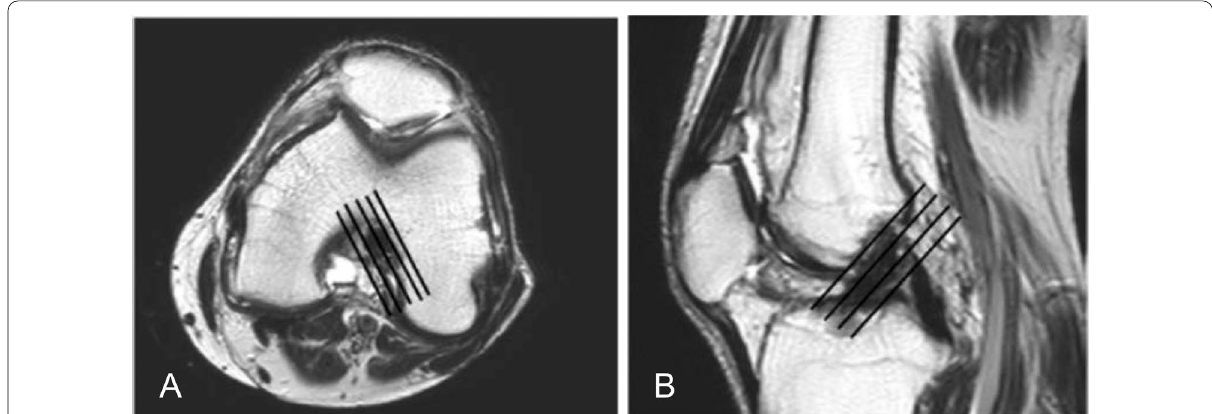
Fig. 1 Oblique sagittal and coronal imaging of ACL was planned using both axial ( A ) and sagittal ( B ) images, respectively (black lines)